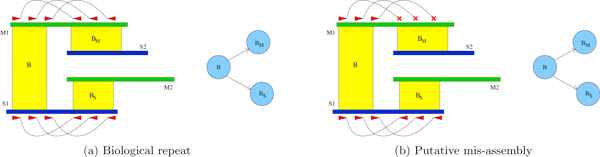
Handling bifurcations in Assemblies Graph. Bifurcations in AG, may spot biological repeats or mis-assemblies. In panel (a), paired reads do not solve the bifurcation and we might face a biological repeat. In panel (b), paired reads on M1 might help us to spot a mis-join in the assembly.